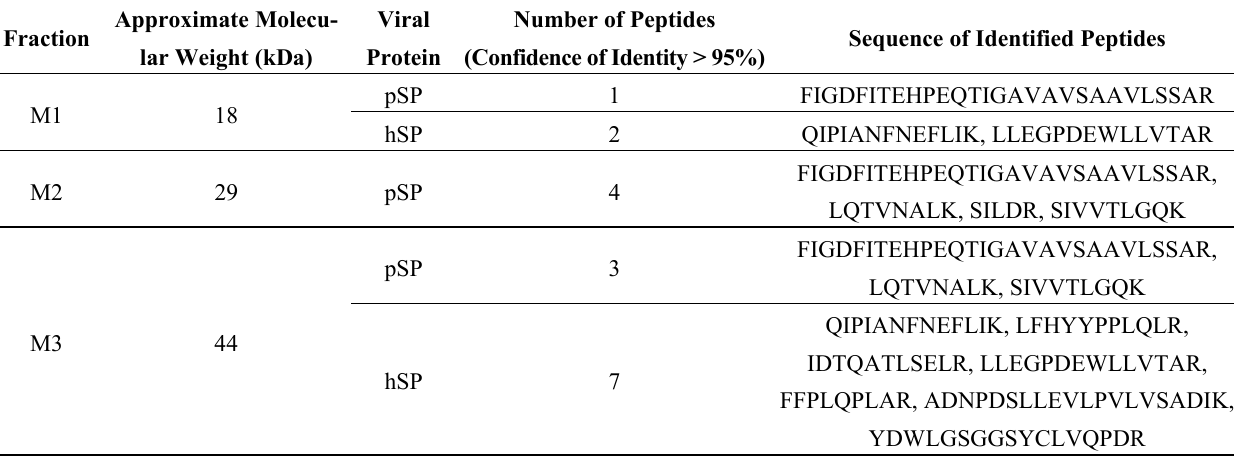
Figure 2. ( A ) Western blot analyses of CBPV purification, using the anti-RdRp antibodies; ( B ) using the anti-CBPV antibodies; ( C ) the anti-pSP antibodies ( D ). Coomassie blue stained of a purified CBPV sample (25 µg of proteins) on an “Any kD” gel. MM: Molecular mass in kDa. Table 1. Identification of immunodetected proteins (fractions M1, M2, M3) from purified CBPV samples using nano-HPLC coupled to